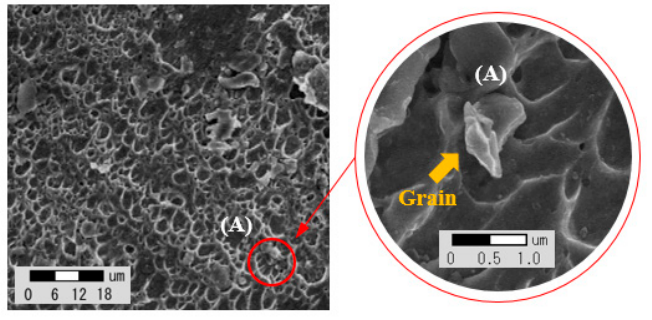
Figure 6. FE-ESEM tester for EDS analysis.